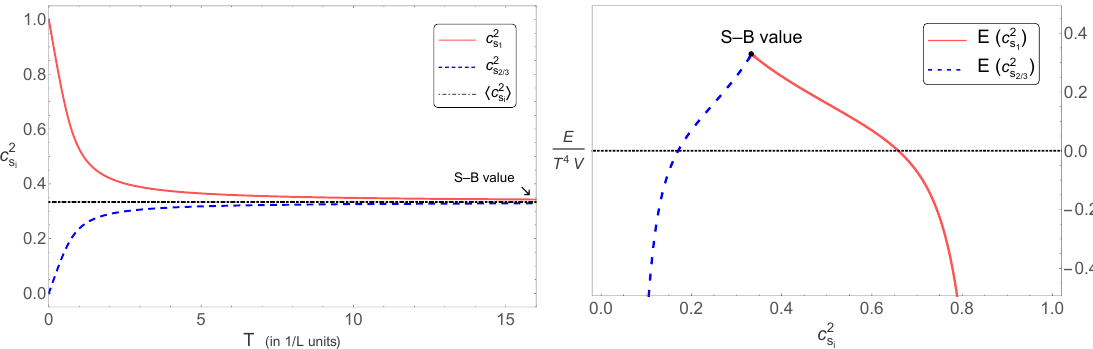
Figure 6. Left figure, we display the two isochoric speeds of sound in between infinite parallel planes, as a function of T in unit of 1/ L . Right figure, we display the total energy of the system as a function of each of the isochoric speeds of sound: The transverse one ( c s